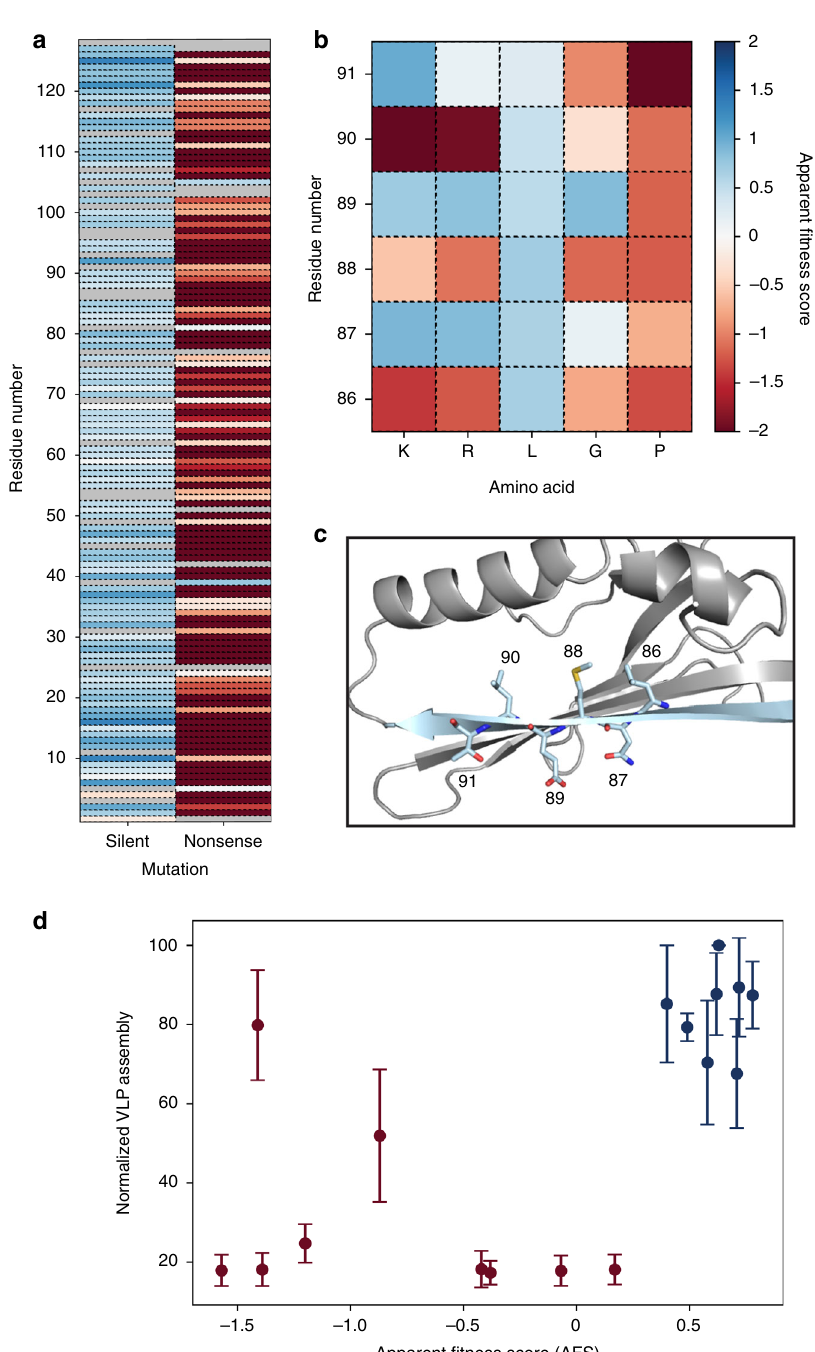
Fig. 3 Validation of apparent fi tness landscape (AFL). a Synonymous and nonsense mutation values are plotted against residue number. b , c Beta sheet G (light blue) shows predicted mutability patterns. d The assembly assay ( n = 3) correlates well with AFS values. Red points were identi fi ed as non- assembling in the AFL, and blue points represent mutants with favorable assembly. Error bars indicate standard